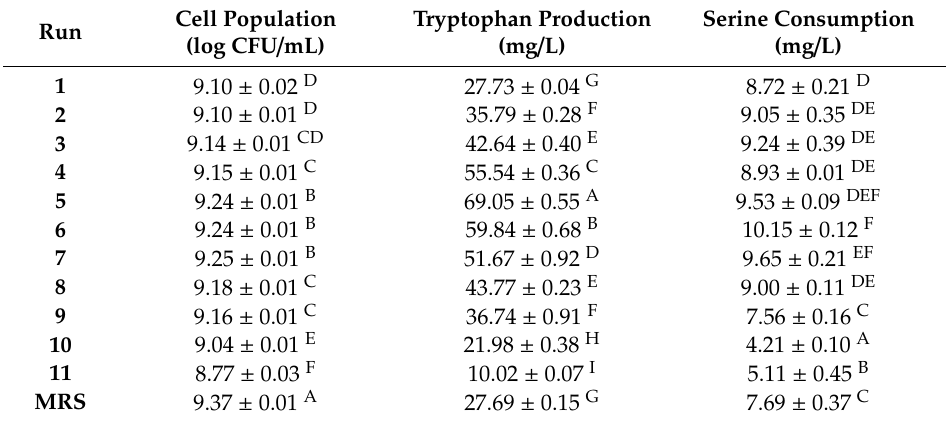
Table 5. Cell population, tryptophan production and serine consumption of P. acidilactici TP-6 for di ff erent media formulation in the steepest ascent